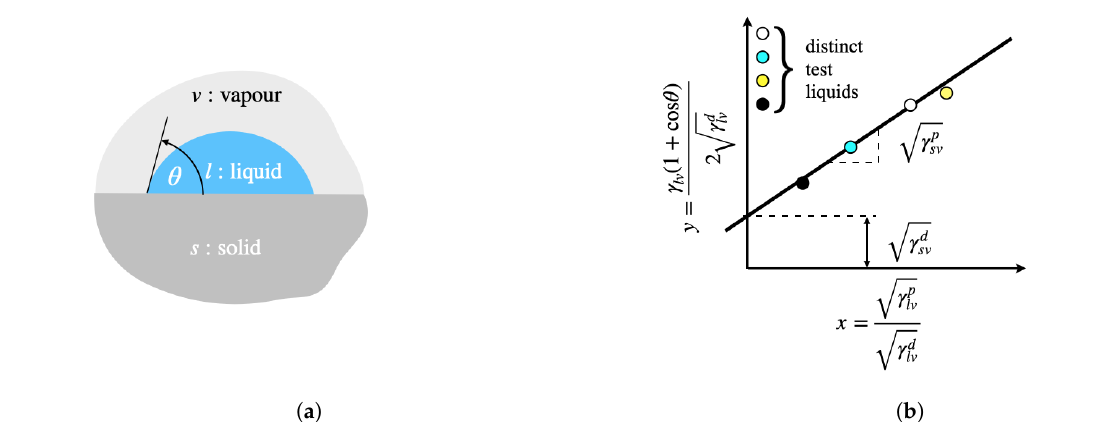
Figure 1. ( a ) Liquid drop resting at equilibrium on a solid surface. ( b ) Schematic Owens–Wendt plot for determining the surface free energy of a solid.